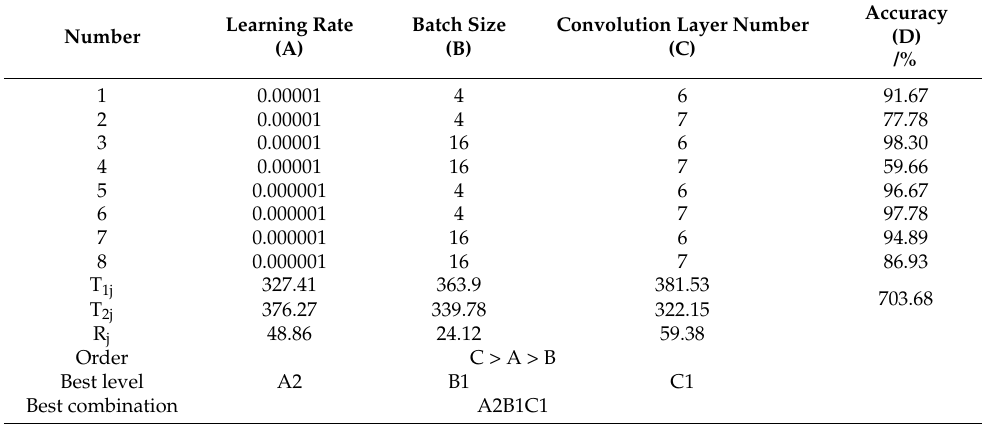
Table 4. The third orthogonal experiment.